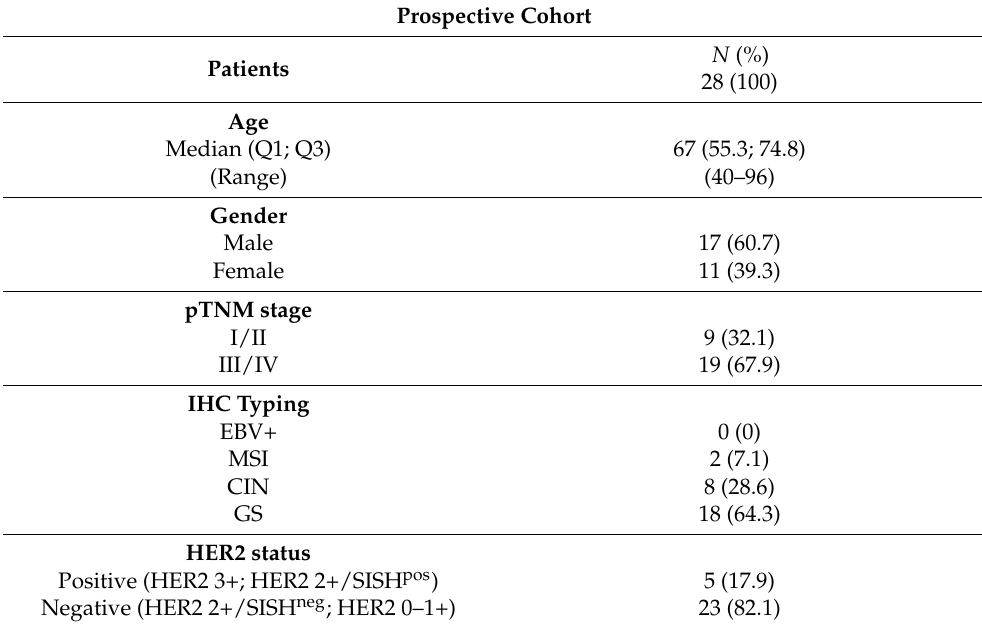
Table 3. Clinicopathologic characteristics of the prospective cohort of GEA